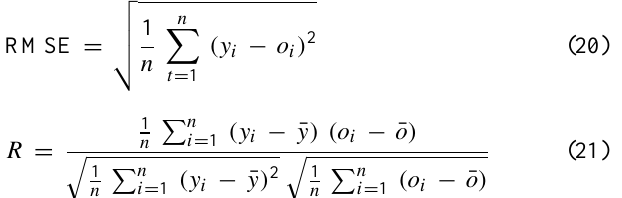
Fig. 5. Location of the study sites 5 6 7